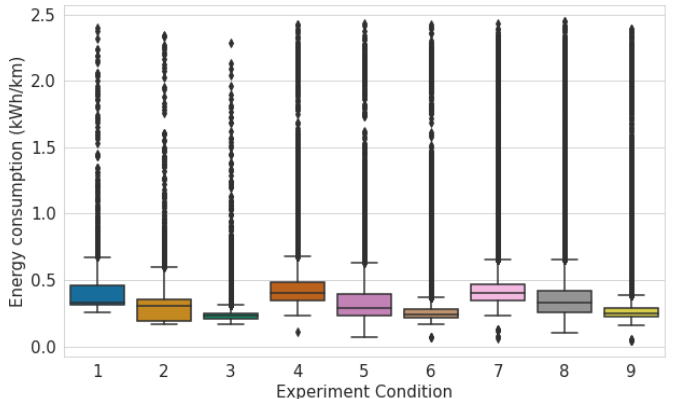
Figure 6. Box plots of energy consumption per kilometer (kWh/km) across all experiment conditions.